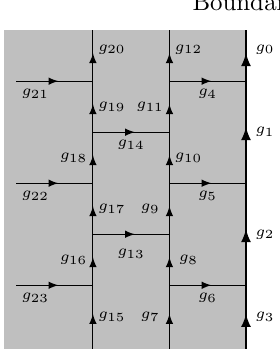
Figure 1 . A portion of an oriented trivalent lattice, on which the extended QD model is de(cid:12)ned. Each edge of the lattice is graced with a group element of a (cid:12)nite gauge group G . Grey region is the bulk, to the left of the boundary (thick